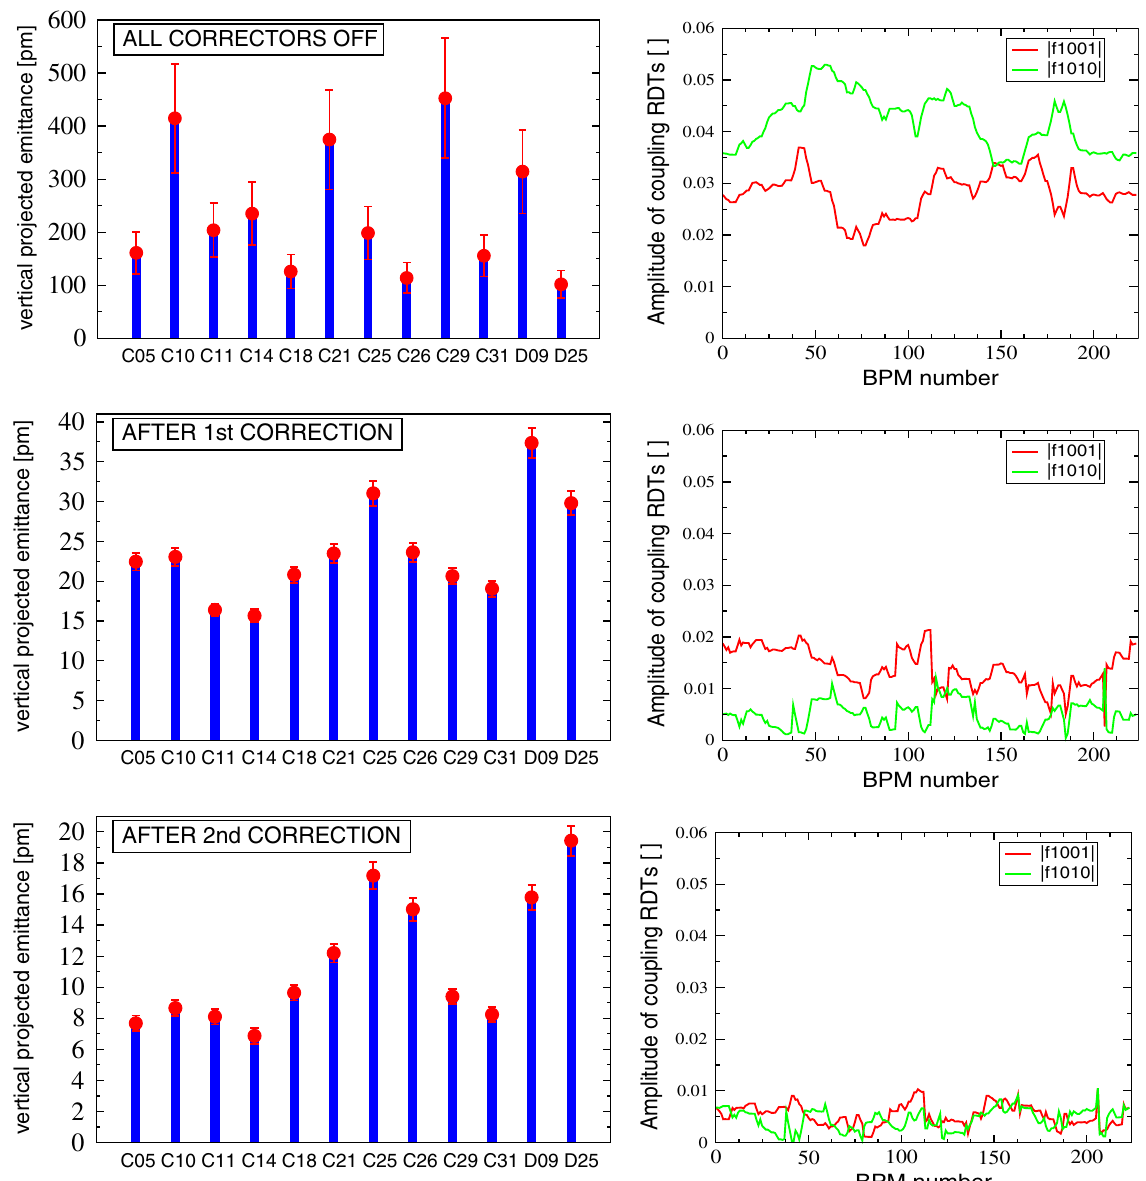
FIG. 4. Left column: Vertical apparent emittances E measured along the ESRF storage ring with all correctors off (upper plot), after y first correction with minimization of coupling RDTs and vertical dispersion (center plot), and after a second measurement and correction (bottom plot). The names in the abscissa refer to the used monitors: ten (out of 11) in-air x-ray monitors (from C05 to C31) and two pinhole cameras (D09 and D25). Right column: Amplitude of the corresponding coupling RDTs.